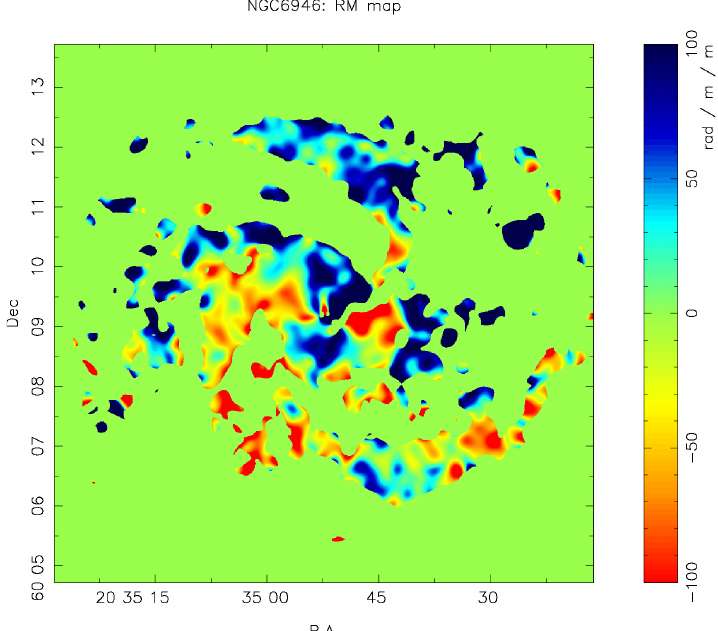
Figure 3. The rotation measure (RM) map obtained by applying the Equation (2) to the C- and X-band polarization maps shown in Figure 2. The foreground RM of + 40rad m − 2 was subtracted based on Beck